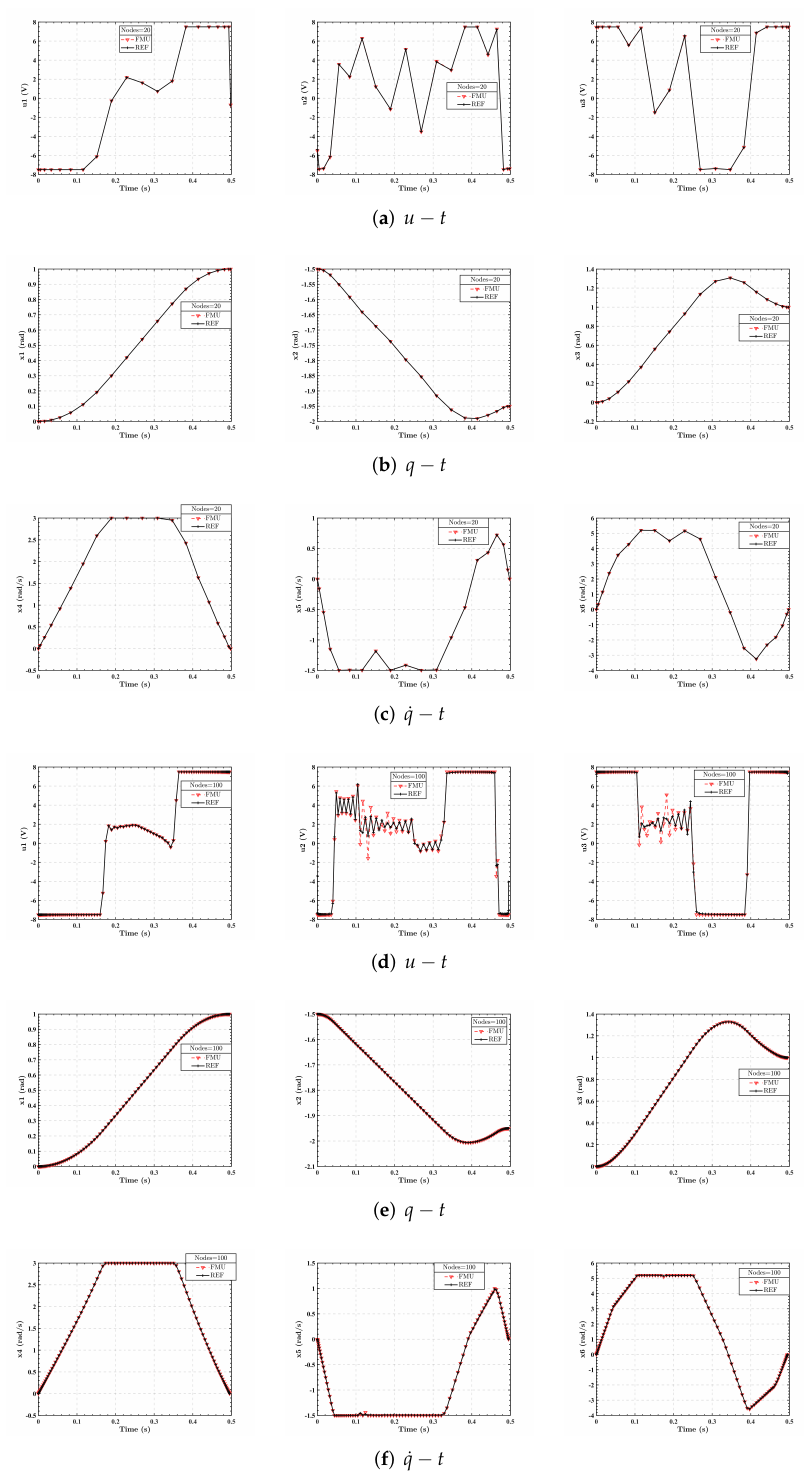
Figure 4. The solutions of the R3M2. Subgraphs ( a – c ) are the solutions using LPM method with 20 nodes; Subgraphs ( d – f ) are the solutions using LPM method with 100 nodes. Subgraphs ( a , d ) print the curve of the input voltage of joint actuators. Subgraph ( b , e ) print the curve of the joint positions. Subgraph ( c , f ) print the curve of the joint velocities. The red curves with triangles ( − (cid:53) − ) refer to the solutions of the improved method with FMU. The black curves with plus signs ( − + − ) refer to the reference